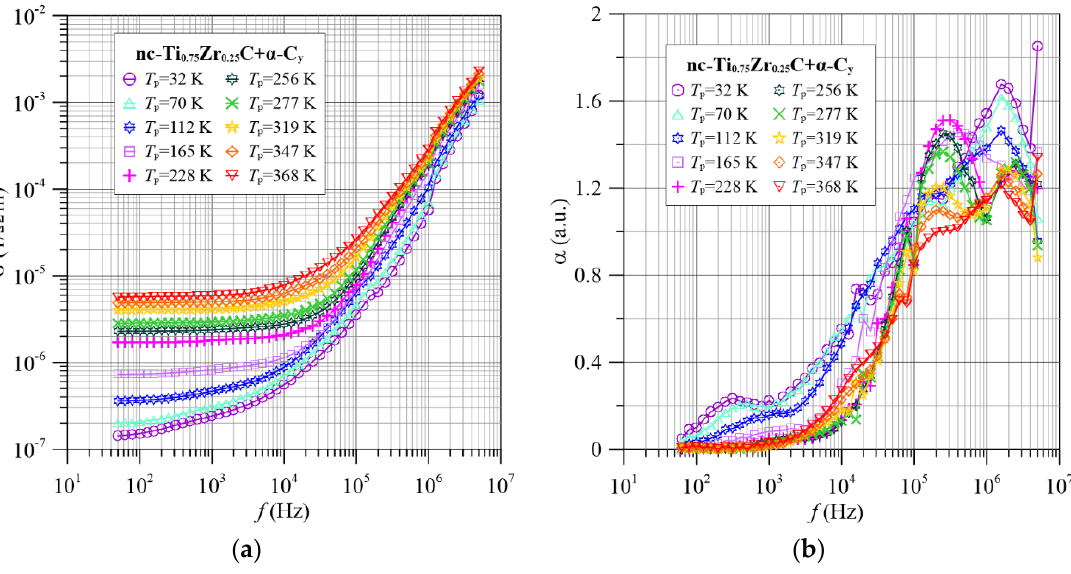
Figure 6. Frequency dependence of conductivity ( a ) and frequency factor α ( f ) ( b ) for selected measurement temperatures for the nc-Ti 0.75 Zr 0.25 C+ α -C y nanocomposite.